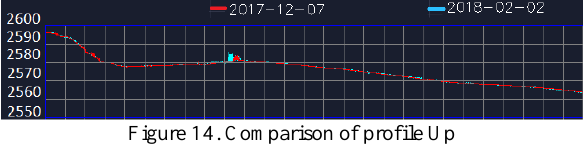
Figure 14. Comparison of profile Up